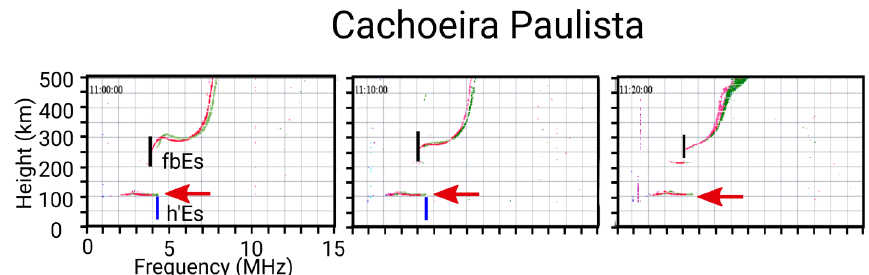
Figure 3. Ionograms over Cachoeira Paulista from 11:00 to 11:20UT on 2 January 2016. The red arrows indicate the presence of Es layers. The black vertical line represents the fb Es parameter, and the top of the blue vertical line marks the virtual height of the Es layer. In the ionograms, the overhead reflections for ordinary and extraordinary waves are red and green, respectively.